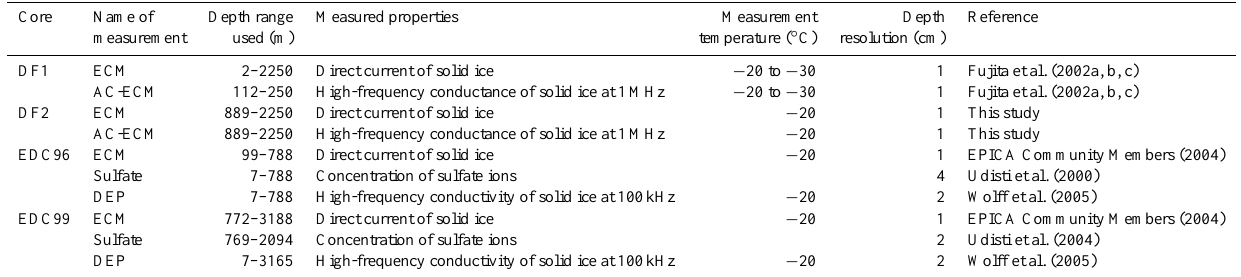
Table 1. Summary of data sets of ice core signals used for